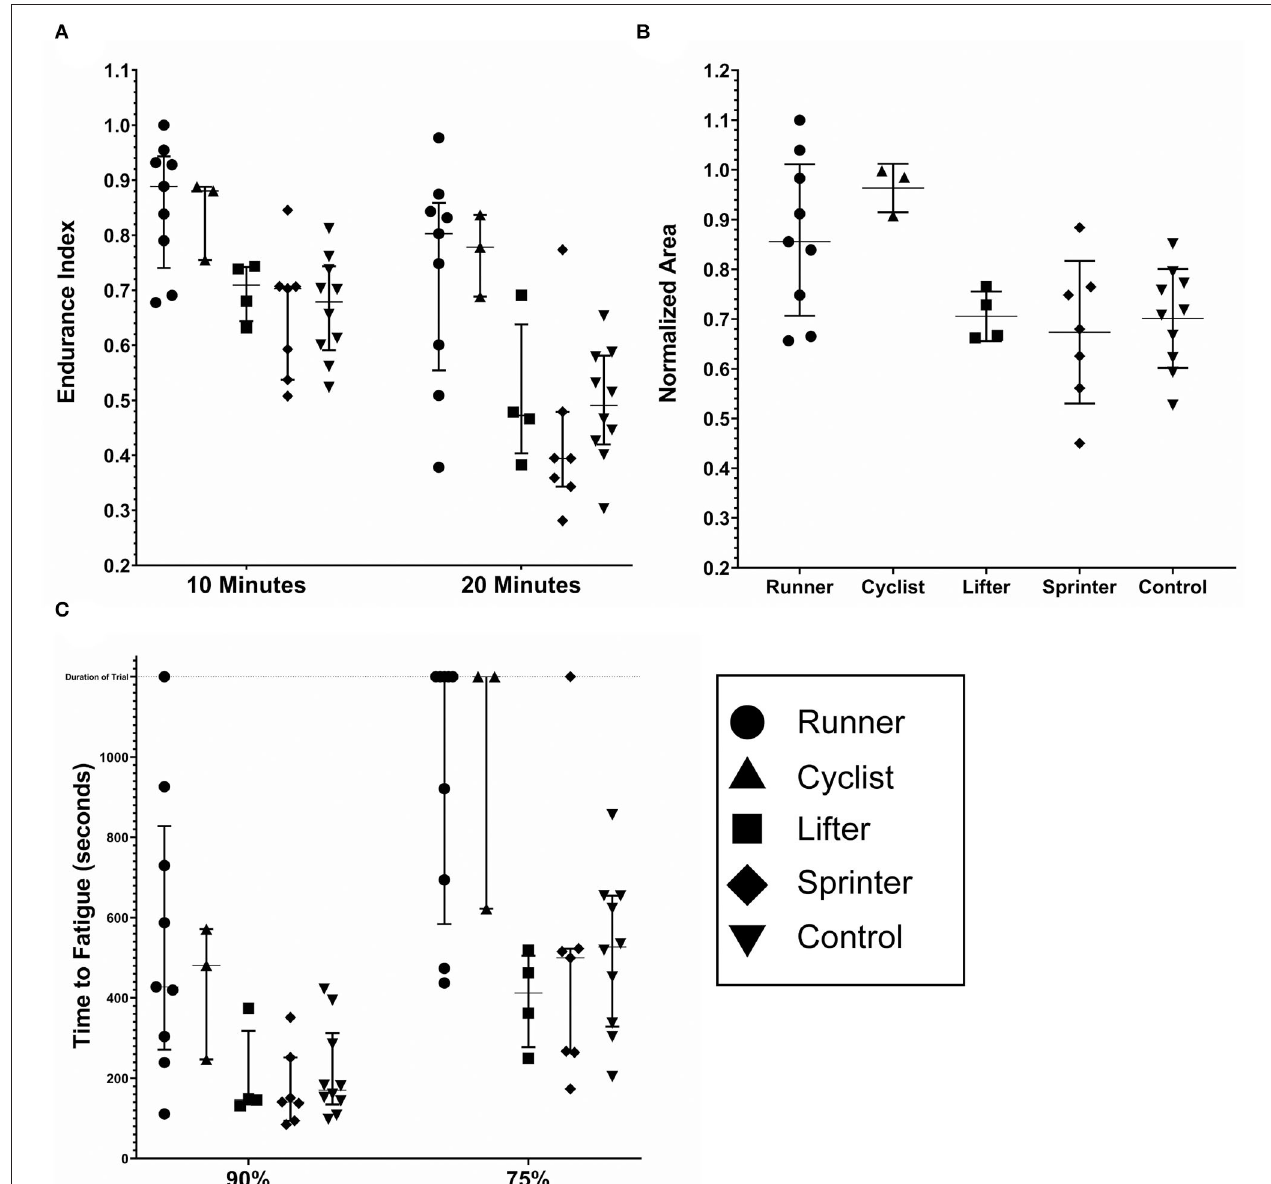
FIGURE 5 | Fatigue metrics by sport; runners ( n = 9), cyclists ( n = 3), lifters ( n = 4) sprinters ( n = 7) and controls ( n = 10). (A) The endurance index as measured at the 10 and 20min timestamp. (B) The normalized area. Some subjects had calculated values above 1.0, due to the processing method. (C) The time to Fatigue to 90% and 75% of the initial force output. The duration of the trail was 1,200s and is noted by the dashed horizontal line. The lines within each data set denote the median and the interquartile range.